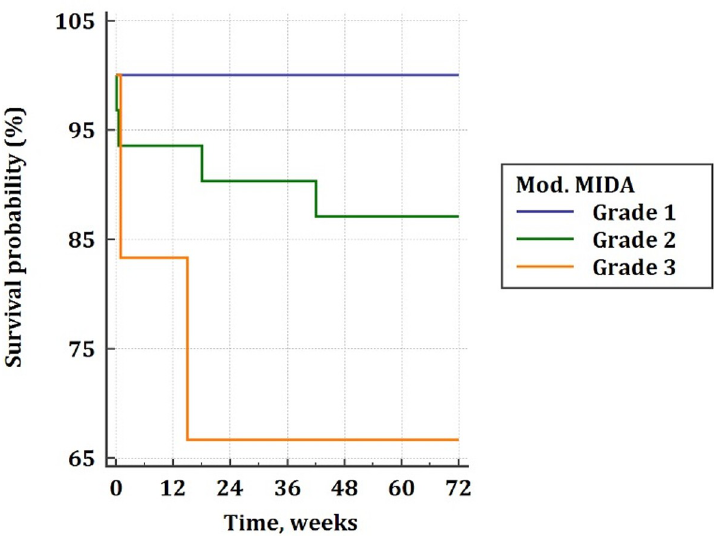
Fig 4. Presentation of survival according to grades of the modified MIDA Score: The Kaplan-Meier curve.